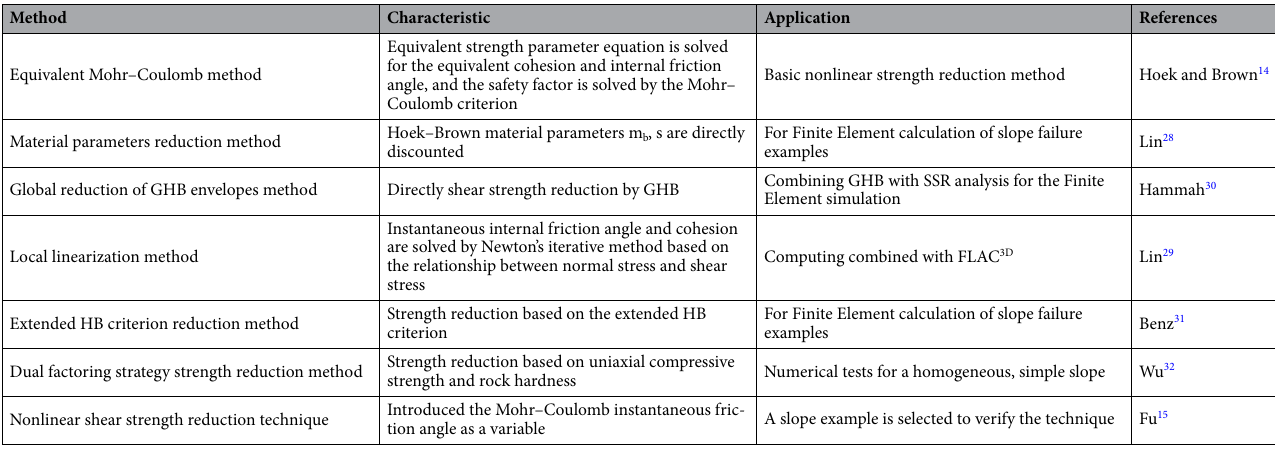
Table 1. The most important nonlinear strength reduction methods used in slope stability